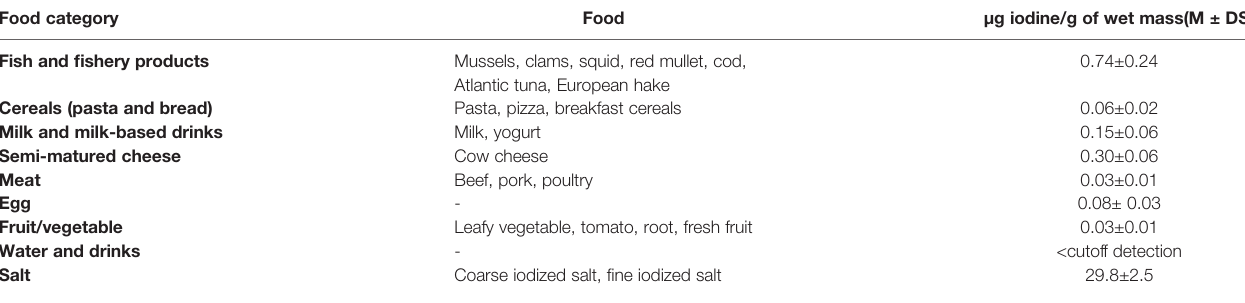
TABLE 1 | Average content of iodine in the most common foods (Italian National Observatory for the monitoring of iodine prophylaxis – OSNAMI). Food category Fish and fi shery products Cereals (pasta and